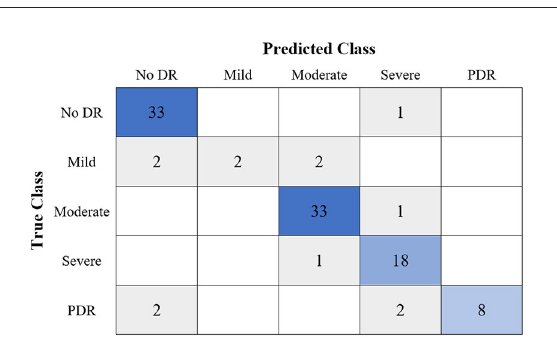
FIGURE8 The confusion matrix of the highest multi-class classification outcome for the GWO-ELM approach using the IDRiD dataset.